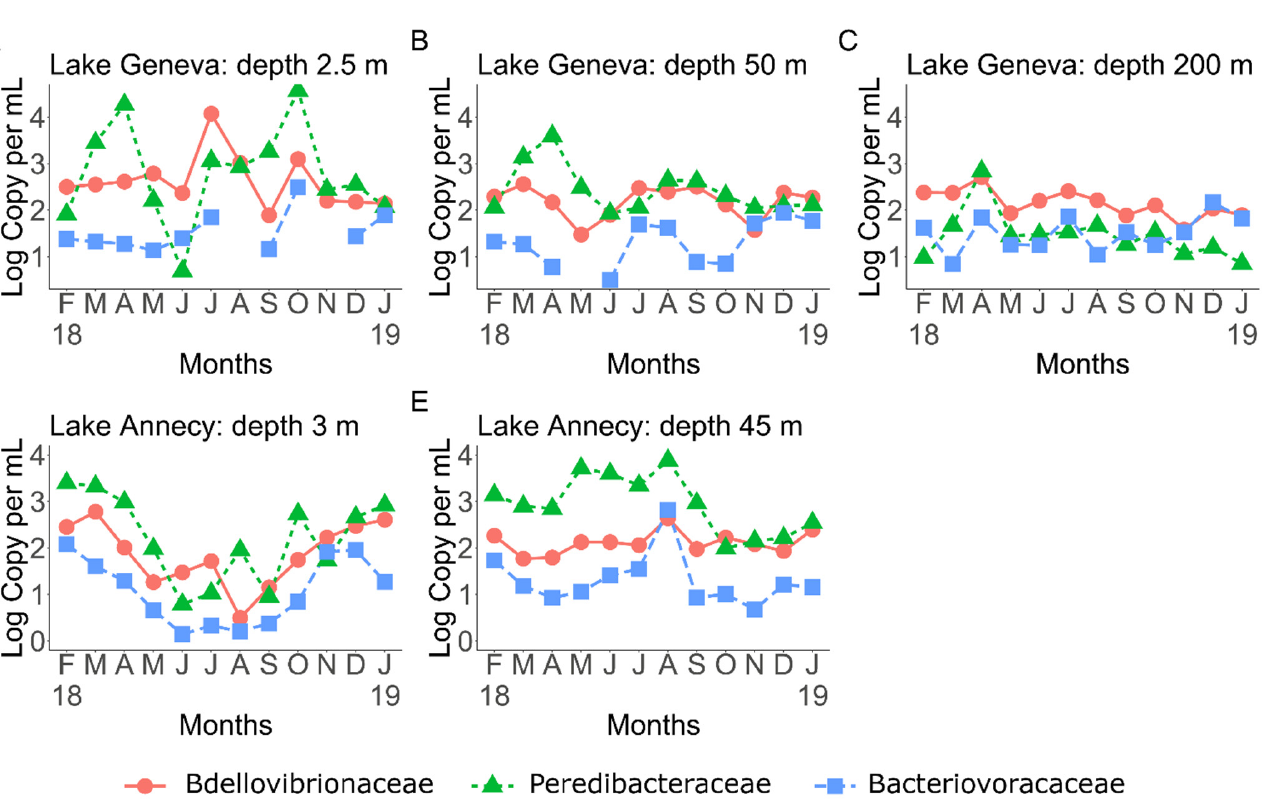
Figure 1. Abundance (copy per mL) distribution and dynamics of the three BALOs families, Bdellovibrionaceae, Peredibacteraceae and Bacteriovoracaceae , over one year (February 2018 to January 2019) in Lake Geneva (at 2.5 m Figure S1, 50 m Figure S2 and 200 m Figure S3) and Lake Annecy (at 3 m Figure S3 and 45 m Figure S5). The x-axes indicates the months, each abbreviated by the first letter